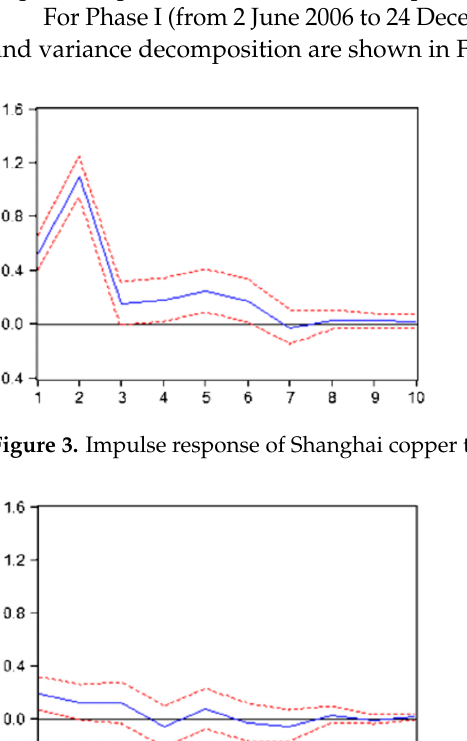
Figure 2. Unit circle of the VAR model in three stages.